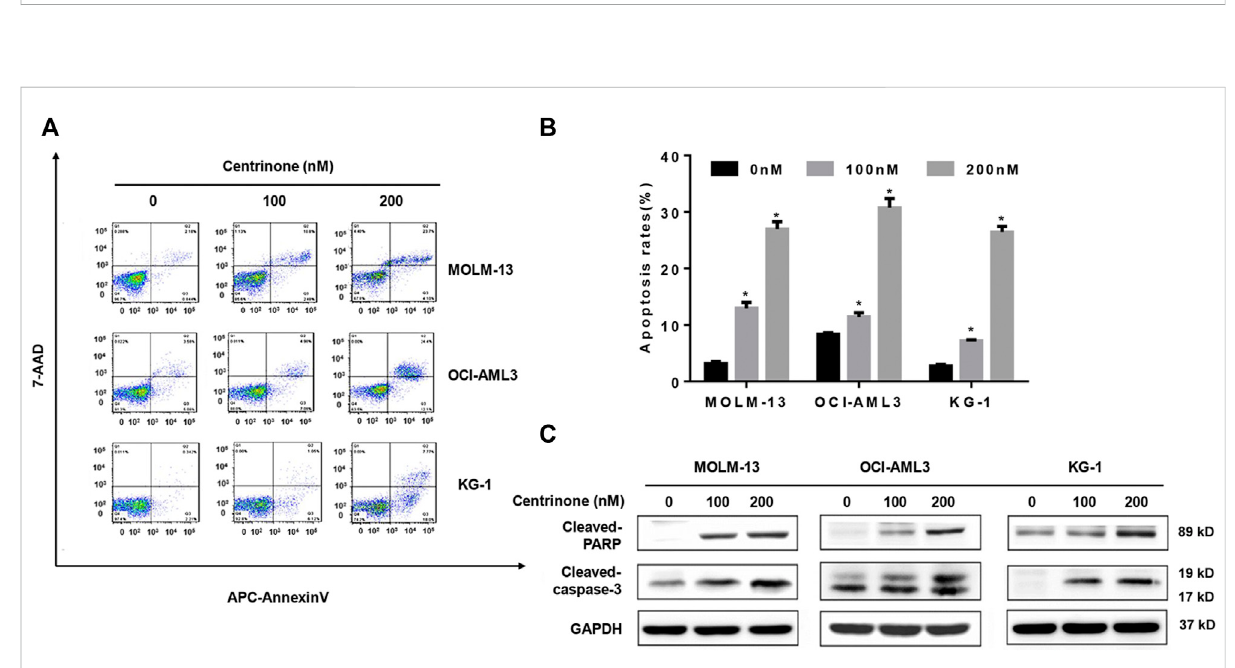
FIGURE 3 Centrinoneinducedthe apoptosis of AML cells via increasing the expression of cleaved Caspase-3 and cleaved PARP. (A) The apoptosis of AML cells treated with different Centrinone concentrations after 72 h was analyzed by fl ow cytometry with Annexin V/7-AAD double staining. (B) Statistical analysis of apoptosis of AML cells treated by Centrinone (compared with the control group, * p < 0.05). (C) The expression of cleaved Caspase-3 and cleaved PARP were detected by Western